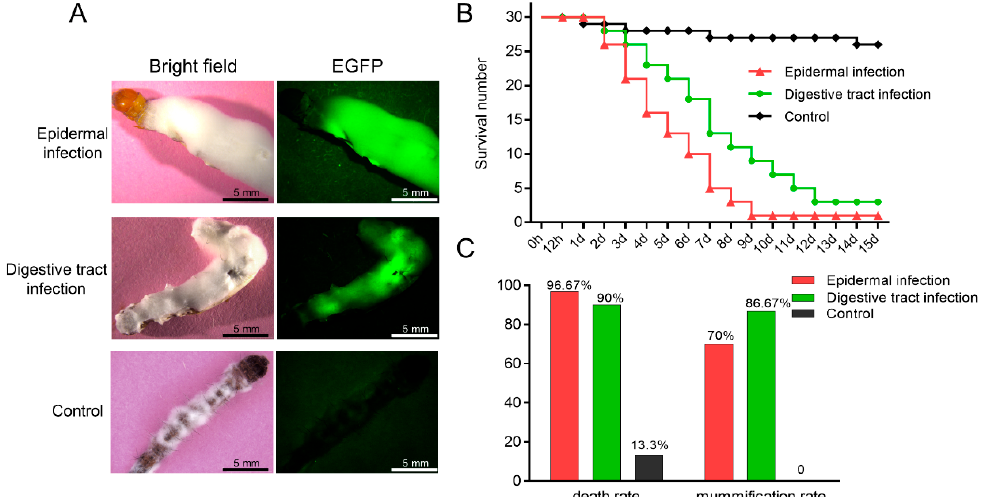
Figure 6. Comparison and statistical analysis of the two infection methods. ( A ) C. farinosa caused larval death and mummification via different modes of infection, and white C. farinosa hyphae grew on the body surface. Wild type C. farinosa was used as control. ( B ) Kaplan–Meier survival curves of T. armoricanus larvae with different infection methods. ( C ) Mortality and mummification rates of T. armoricanus larvae using different infection methods. Uninfected larvae were used as control .